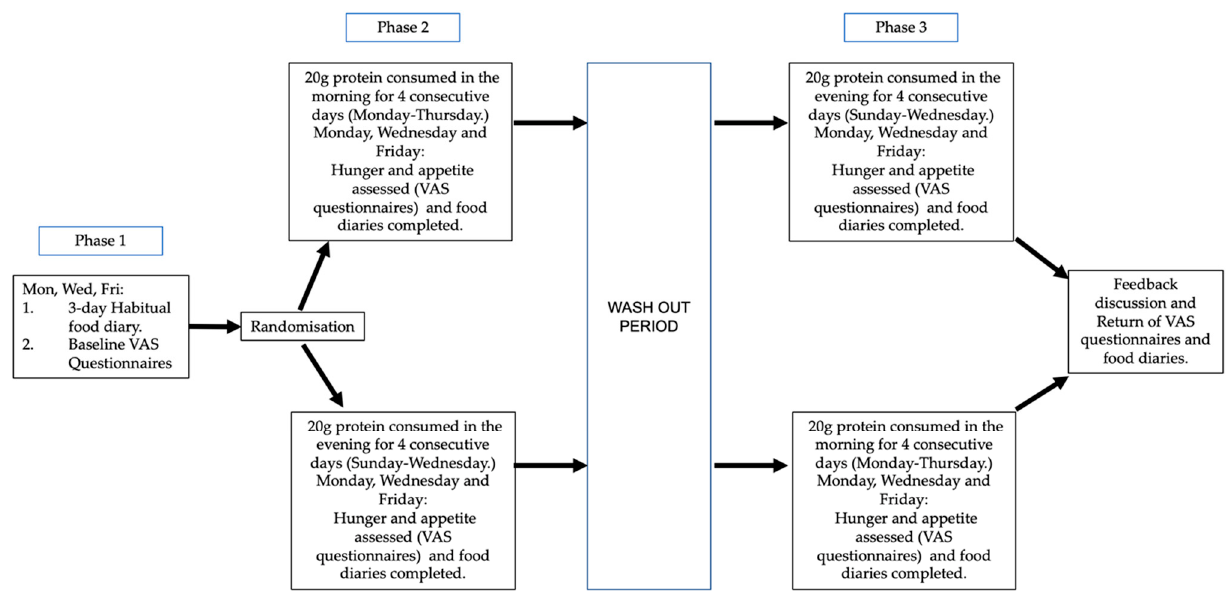
Figure 1. Graphical summary of trial workflow.